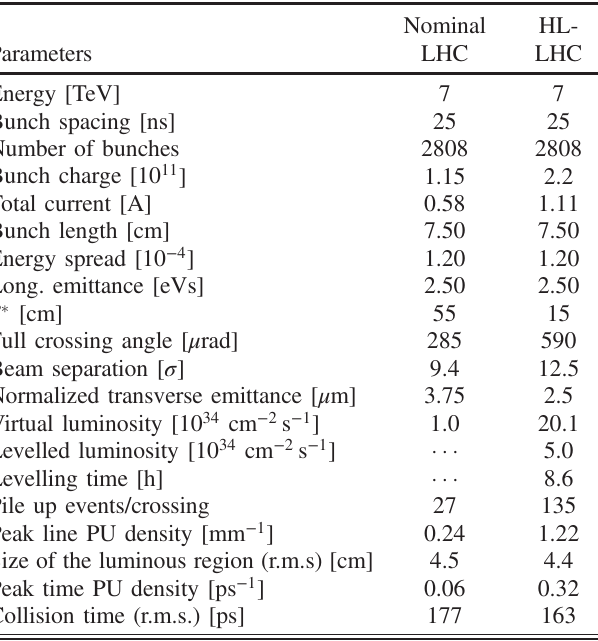
TABLE I. Baseline parameters of the HL-LHC (25 ns version [9]) and comparison with the nominal LHC